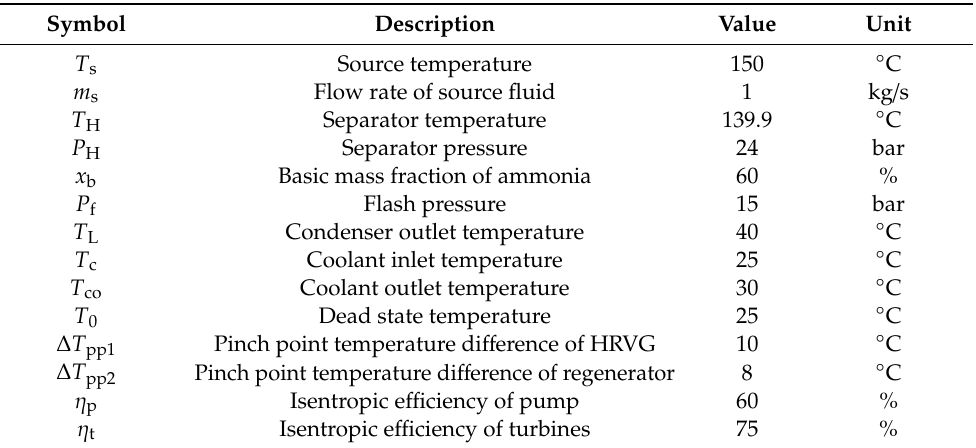
Table 1. Base conditions of the system.